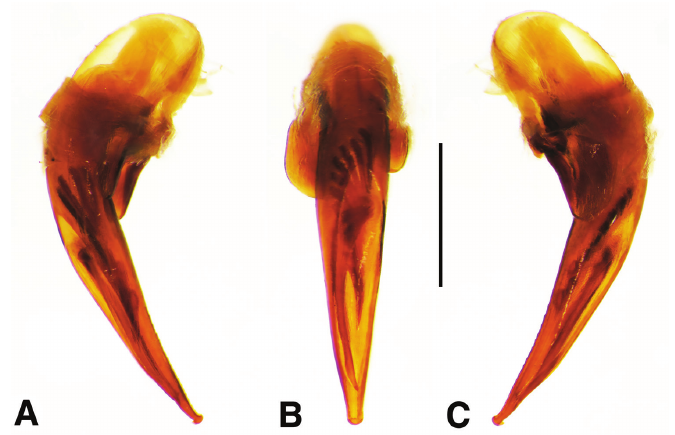
Figure 23. Digital images of male genitalia of Selenophorus seriatoporus species group, S. spinosus sp. n. A right lateral aspect B dorsal aspect C left lateral aspect. Scale bar 1